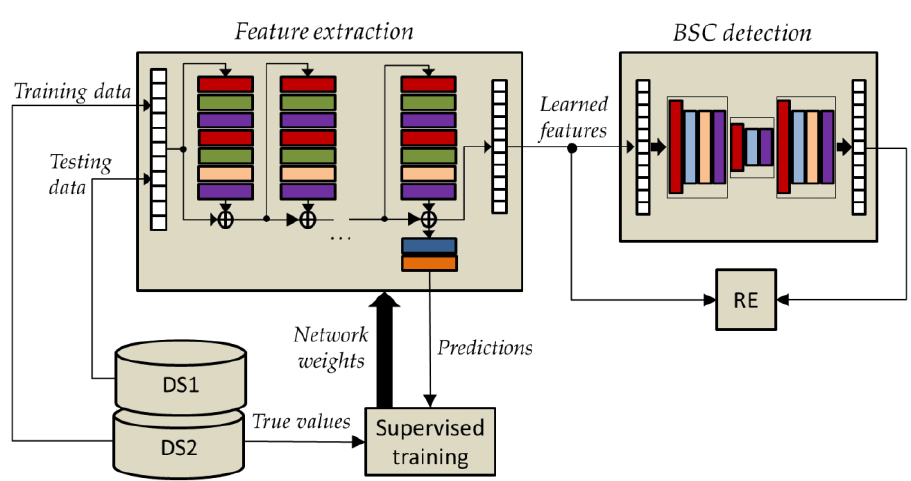
Figure 6. General overview of the joined architecture including the TCN and BLSTM-AE net- works.